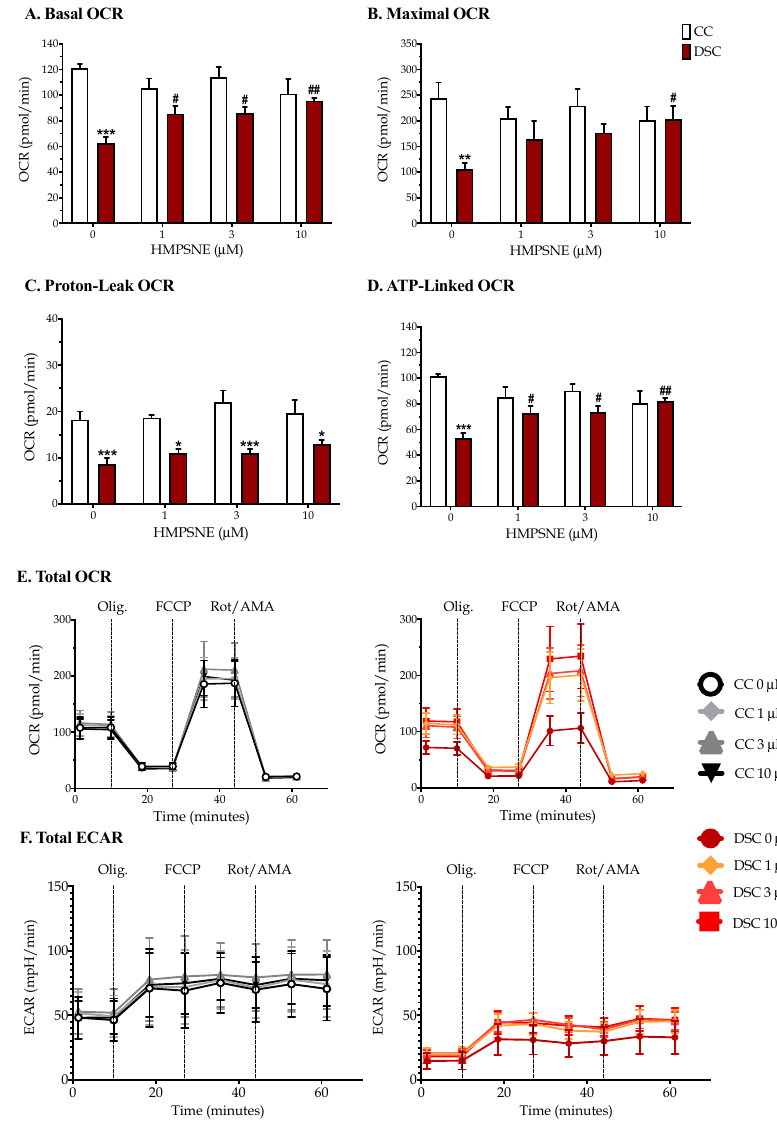
Figure 5. The 3-MST inhibitor HMPSNE normalizes the suppressed oxidative phosphorylation in DS cells. ( A ) Basal OCR; ( B ) Maximal OCR; ( C ) Proton-Leak OCR; ( D ) ATP-Linked OCR; ( E ) Total OCR; ( F ) Total ECAR. Cellular bioenergetics was quantified with the Seahorse extracellular flux analyzer. Each bar and line represent the mean ± SEM from at least 3 independent experiments of the selected normal Detroit 551 (CC) and Down syndrome Detroit 539 (DSC) fibroblasts under baseline conditions and when treated with 1, 3 or 10 µM HMPSNE for 24 h. * p < 0.05, ** p < 0.01, and *** p < 0.001 indicate that basal metabolic parameters were significantly lower in DSCs than in CCs; # p < 0.05 and ## p < 0.01 indicate a significant stimulatory effect of HMPSNE in DSCs compared to the values in the absence of the 3-MST inhibitor.